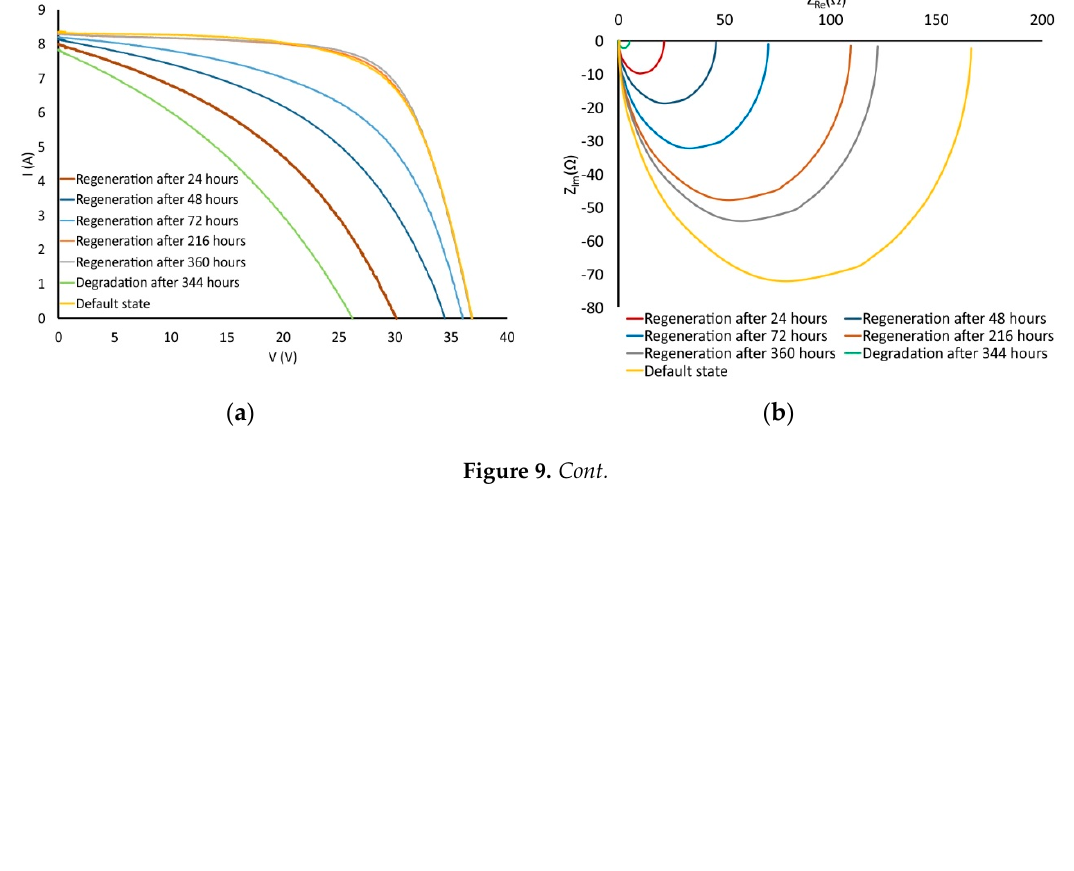
Figure 8. ( a ) I-V curves during degradation for PV cell. ( b ) Cole-Cole curve during degradation for PV cell. ( c ) Dark I-V curve during degradation for PV cell.